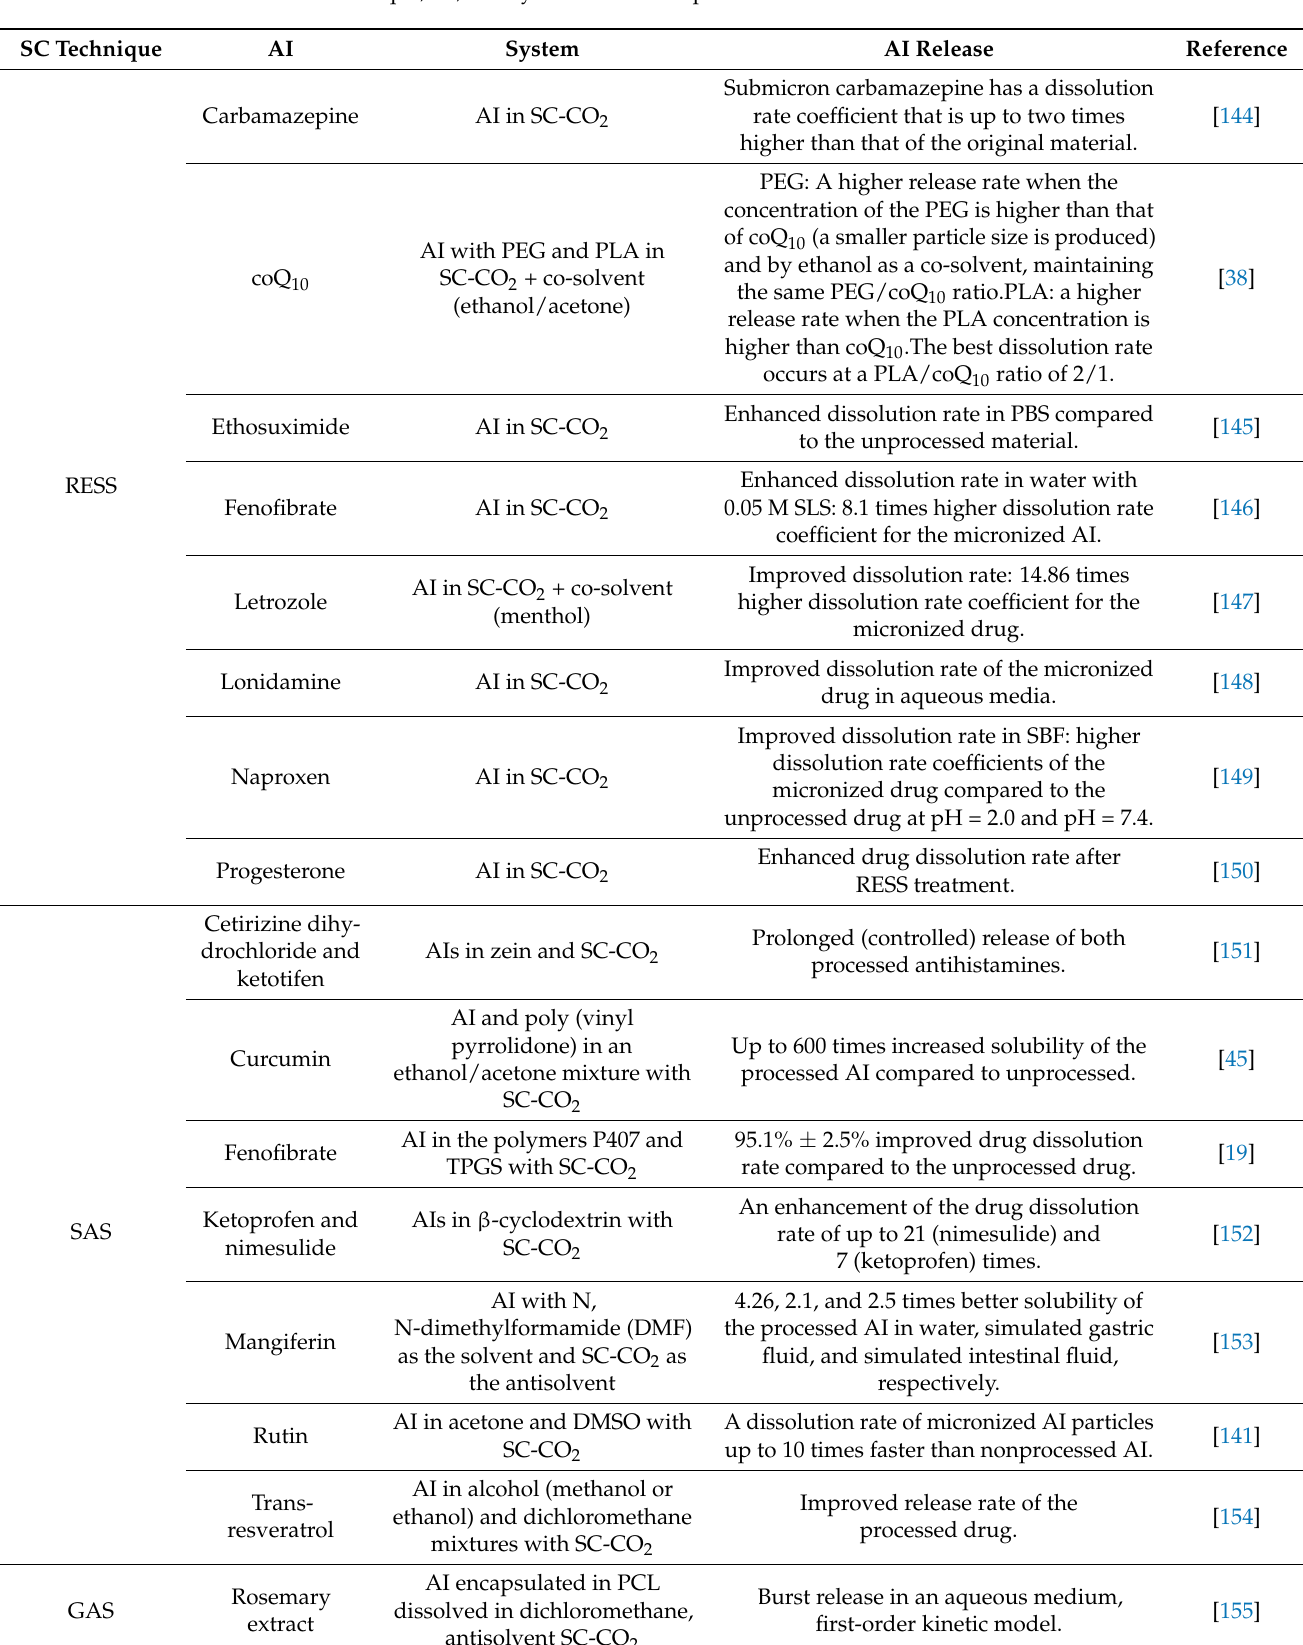
Table 1. The results of AI release in in vitro drug dissolution tests, obtained by the selected SC technique, AI, and system of AI